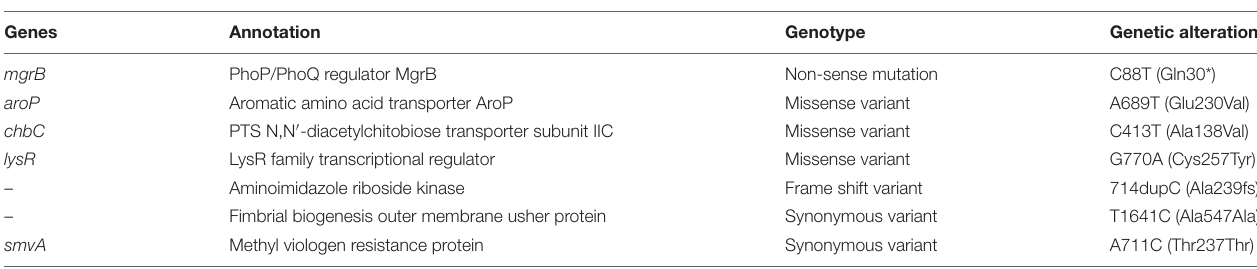
FIGURE 1 | Phylogenetic relationship between K. pneumoniae KP1-1, KP1-2 and a total of 631 ST11 K. pneumoniae strains retrieved from NCBI GenBank. The lines connecting the circles indicate the clonal relationship between different isolates. The scale bar represents a pairwise allelic difference of core genome multilocus sequence typing (cgMLST) loci. The number of isolates from each province is given in square brackets. The solid line indicates the pairwise allelic differences of two isolates is less than 50 alleles. Branches longer than 50 allelic differences are proportionally shortened and are represented by dashed lines. The two yellow circles indicate K. pneumoniae KP1-1, KP1-2. TABLE 3 | Genetic alterations between the isolates KP1-1 and